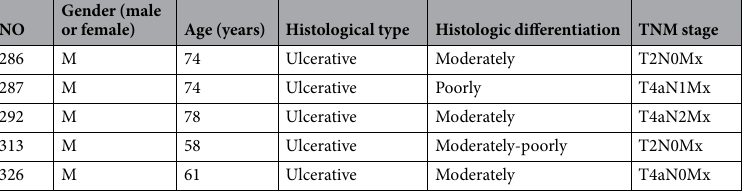
Table 1. The information of patients with gastric cancer subjected to circRNA expression profile chip assay.